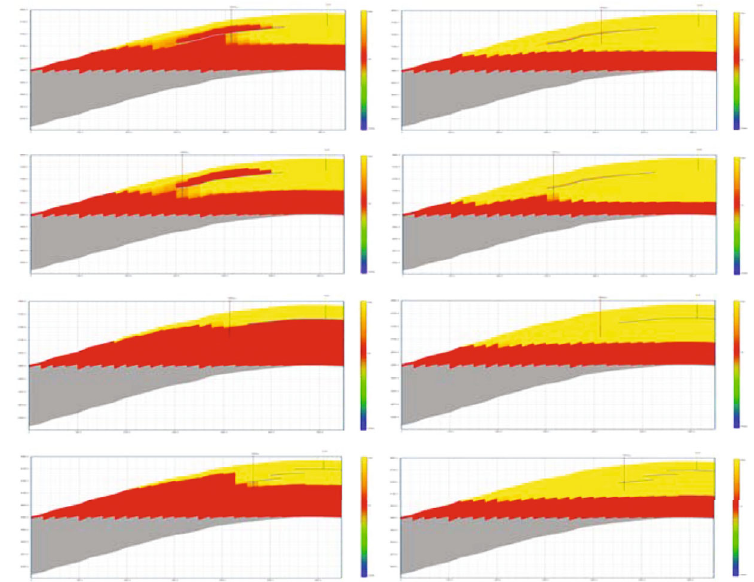
Figure 21: Variation of the gas-liquid interface of four combined relationships in vertical injection and vertical production mode.